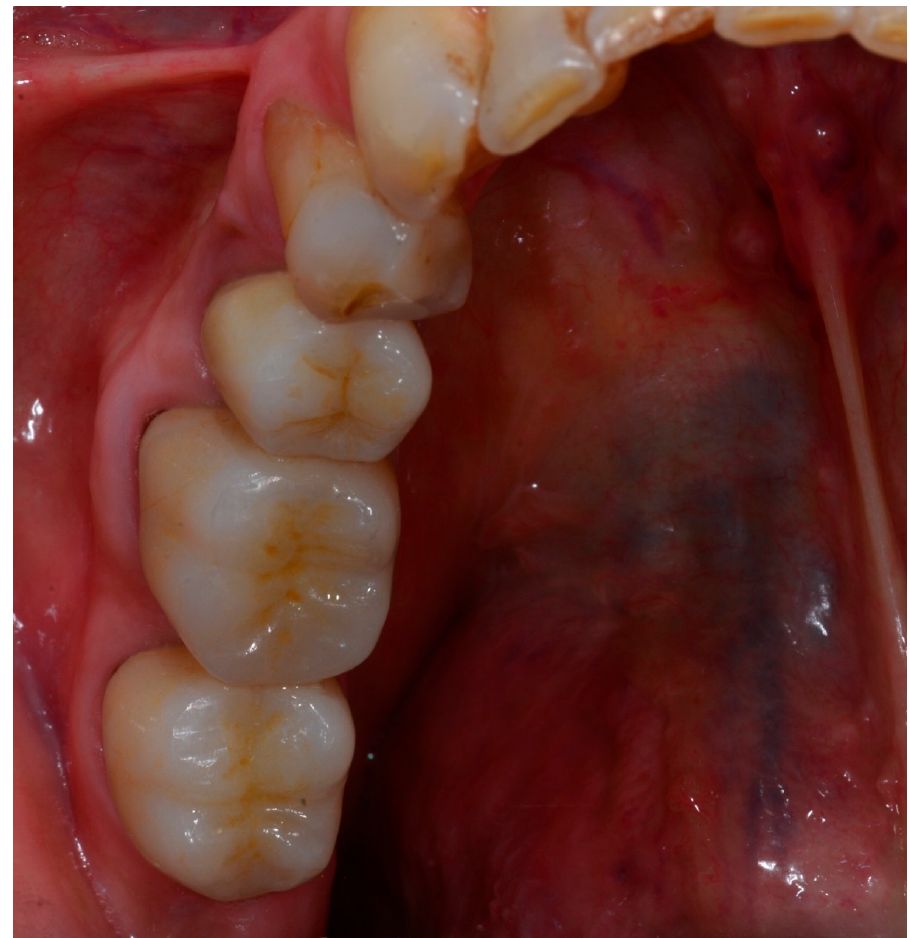
Figure 3. Monolithic zirconia crowns (1-year follow-up).